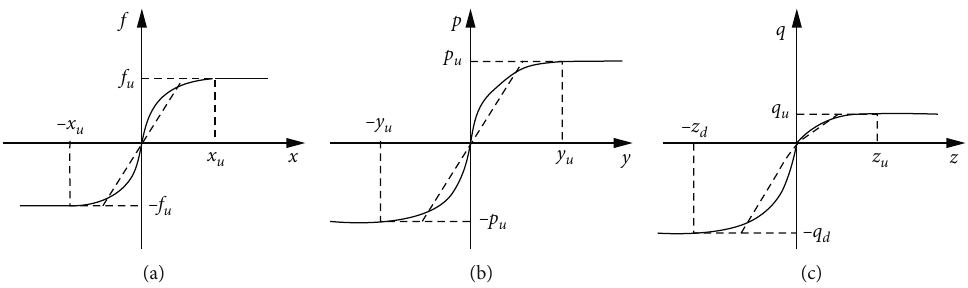
Figure 3: Force-displacement relationships for nonlinear soil springs. (a) axial, (b) transverse lateral, and (c) transverse